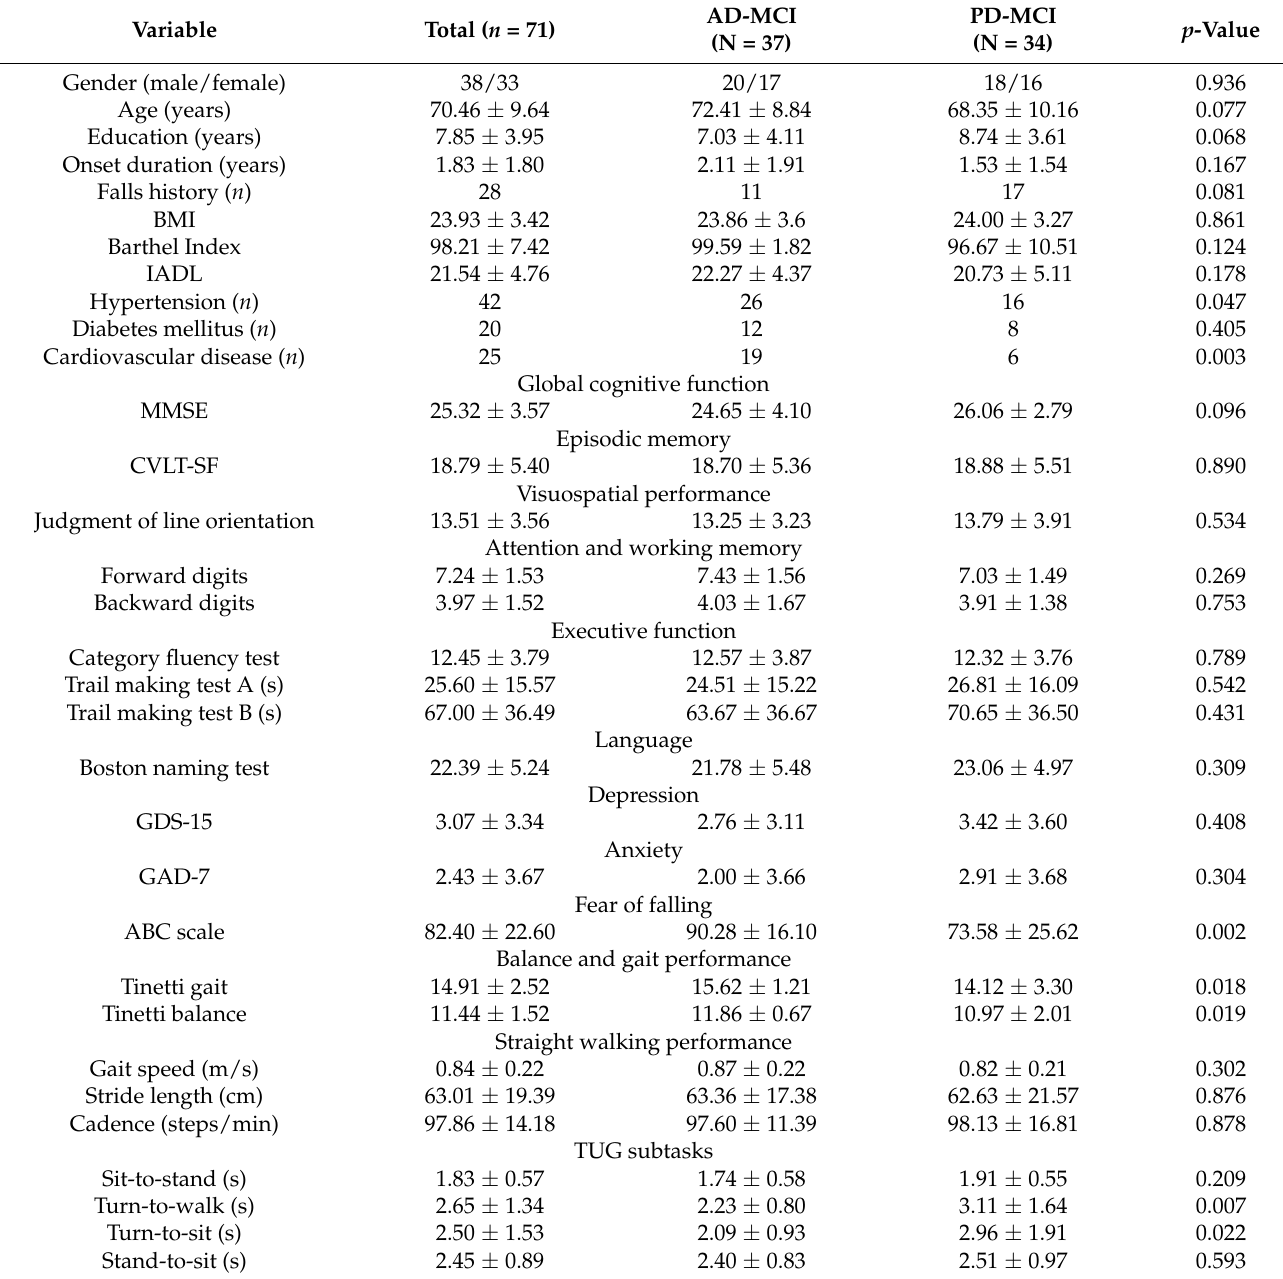
Table 1. Comparison of participants’ characteristics between the AD-MCI and PD-MCI groups ( n =